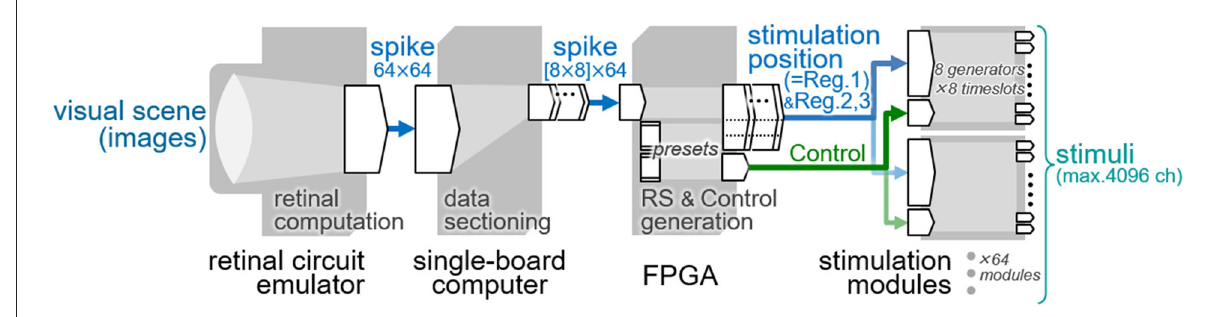
FIGURE10 Block diagram of the testing system of the dynamic operation. The data flow from the left to right.